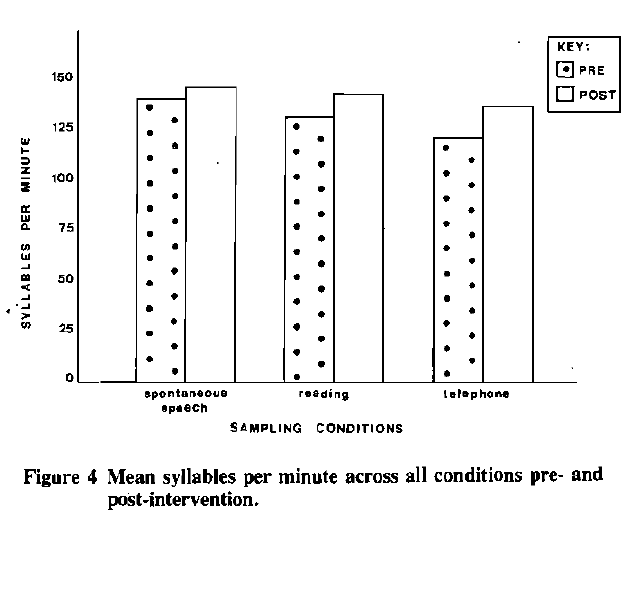
Figure 4 Mean syllables per minute across all conditions pre- and